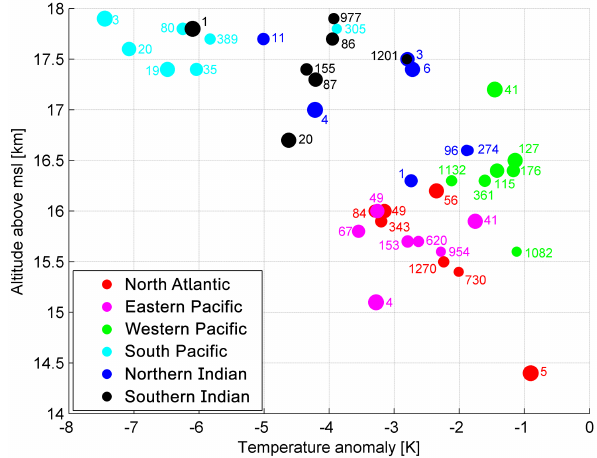
Figure 7. Temperature anomaly vs. altitude of the coldest point for different ocean basins and different storm intensities. The colors denote different basins. The circle size denotes different intensi- ties and increases with intensity, from the smallest to the biggest, in the following order: TD–TS–Cat1–Cat2–Cat3–Cat4–Cat5. The numbers represent the case number used for the